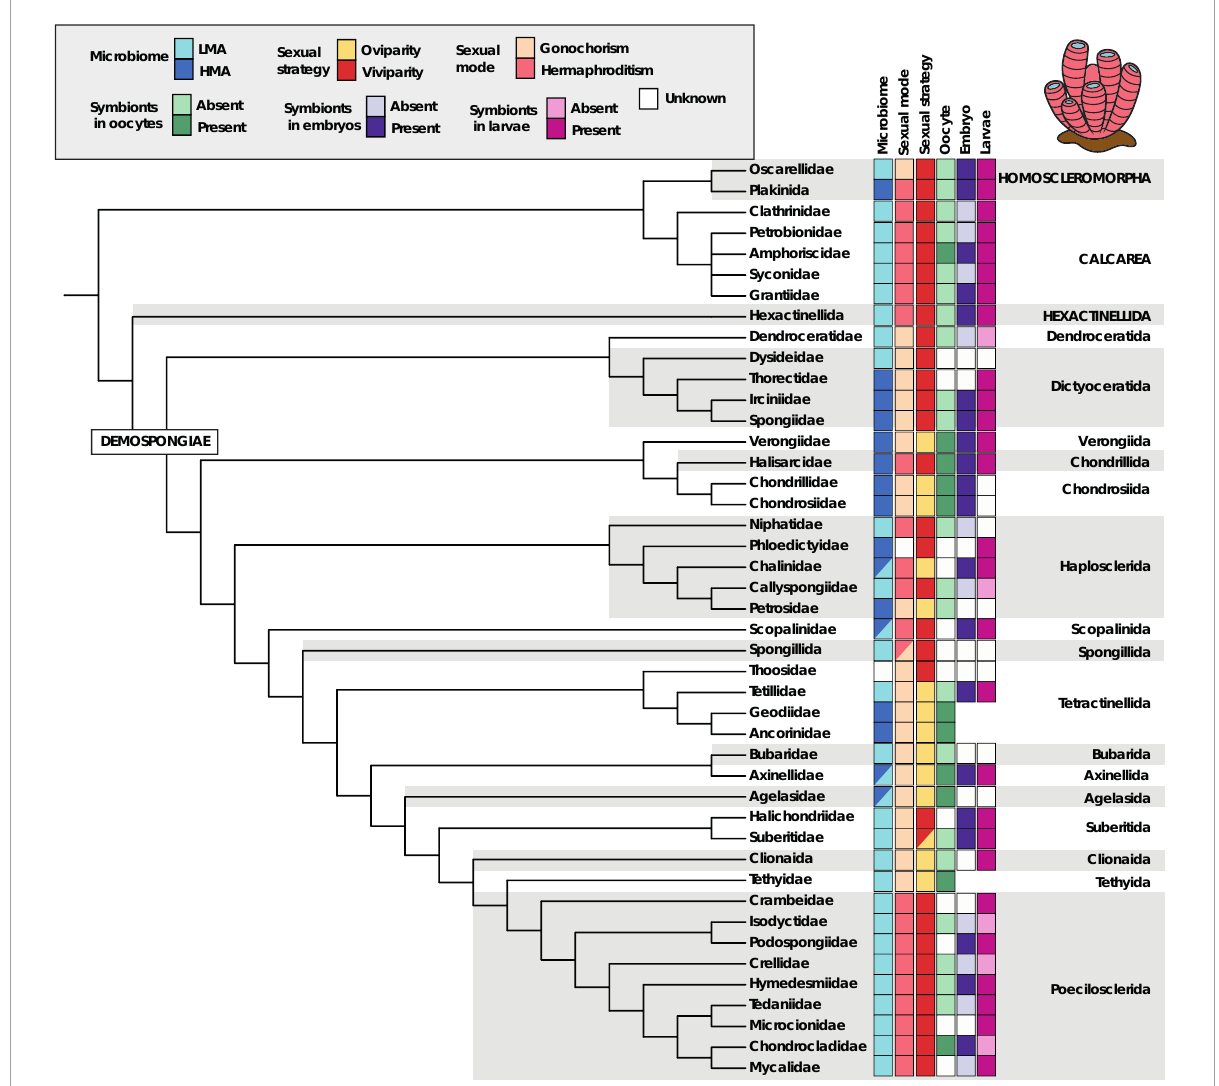
FIGURE7 Phylogenetic backbone for the phylum Porifera to show presence/absence of several biological traits related to symbiont abundance, reproduction, and symbiont presence in developmental stages. Note the class names are shown in capital letters, while order and family names are in lowercase